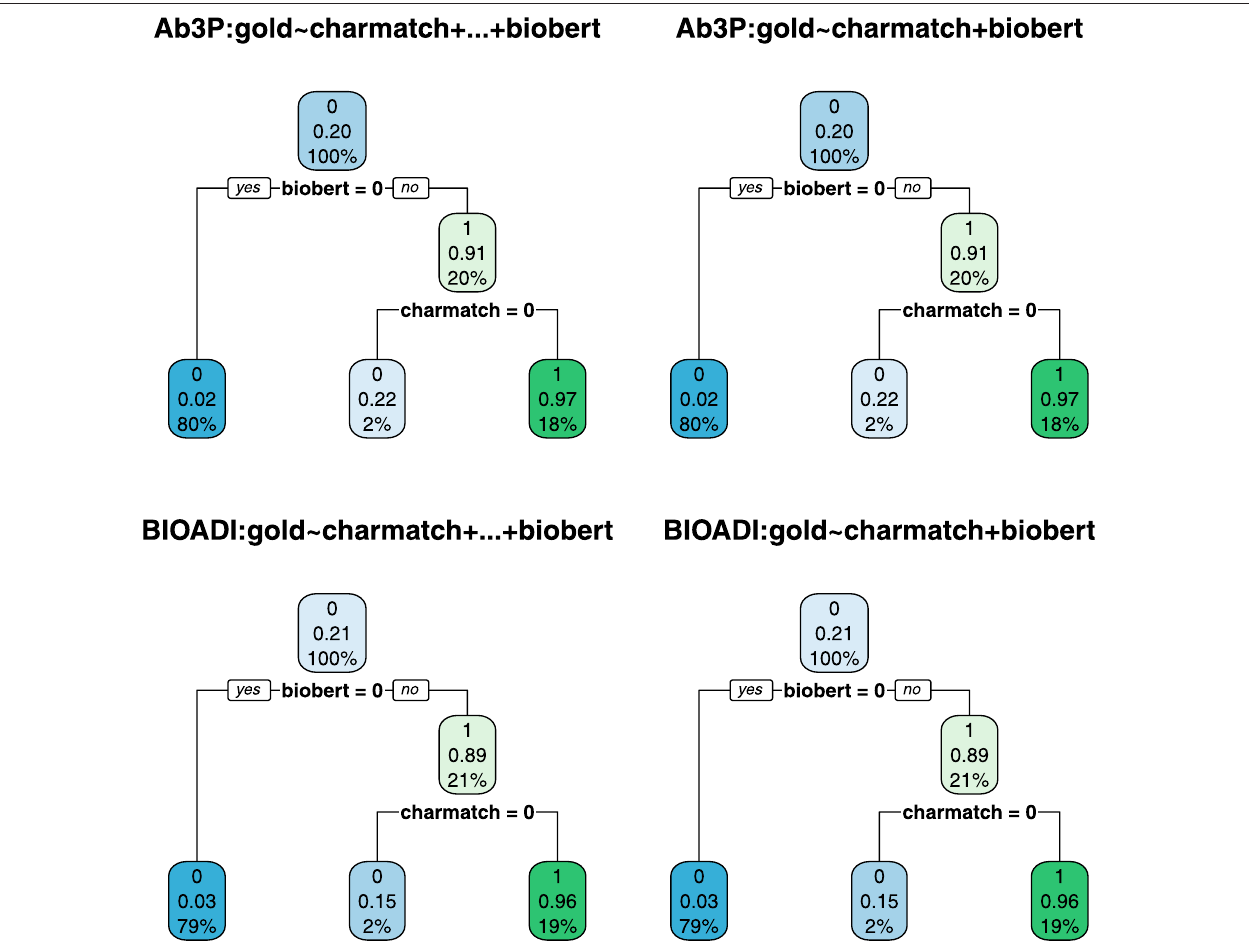
FIGURE6| Thedecisiontreesontheleftarebasedon Eq.3 whereasthetreesontherightarebasedon Eq.2 .Thefactthatthetreesontheleftarethesameasthe trees on the right suggests that 2 features ( charmatch and biobert ) are as useful as all 7 ( rank, charmatch, bert, bart, ernie, t5 and biobert ).